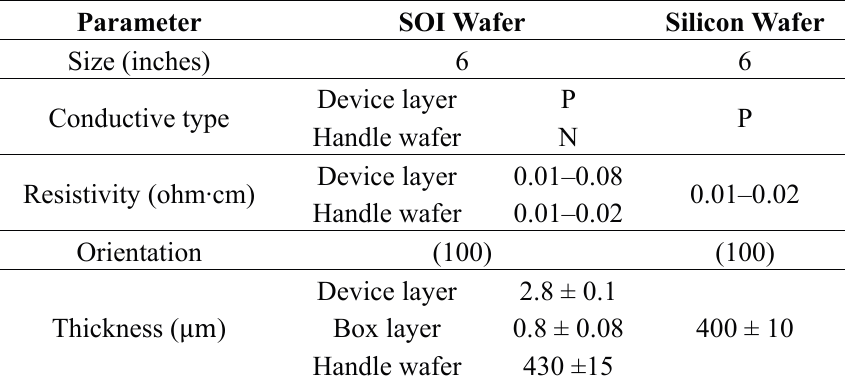
Table 2. The detailed parameters of the silicon wafer and SOI